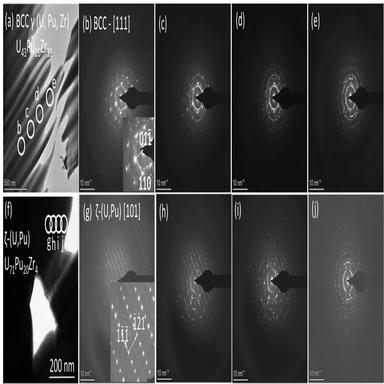
Both the BCC γ -(U, Pu, Zr) phase (a-e) and ζ -(U, Pu) phase (f-j) can show amorphization halos and polygonization rings at the thin areas of TEM sample (site e in (a) and site j in (f)). The reason may be attributebd to radiation damage from the FIB since it is sample thickness dependent with the thicker region showing less effects. However, the oxidation tendency of U and Pu cannot be ruled out since they were close to 1 hour exposure to air during sample loading.